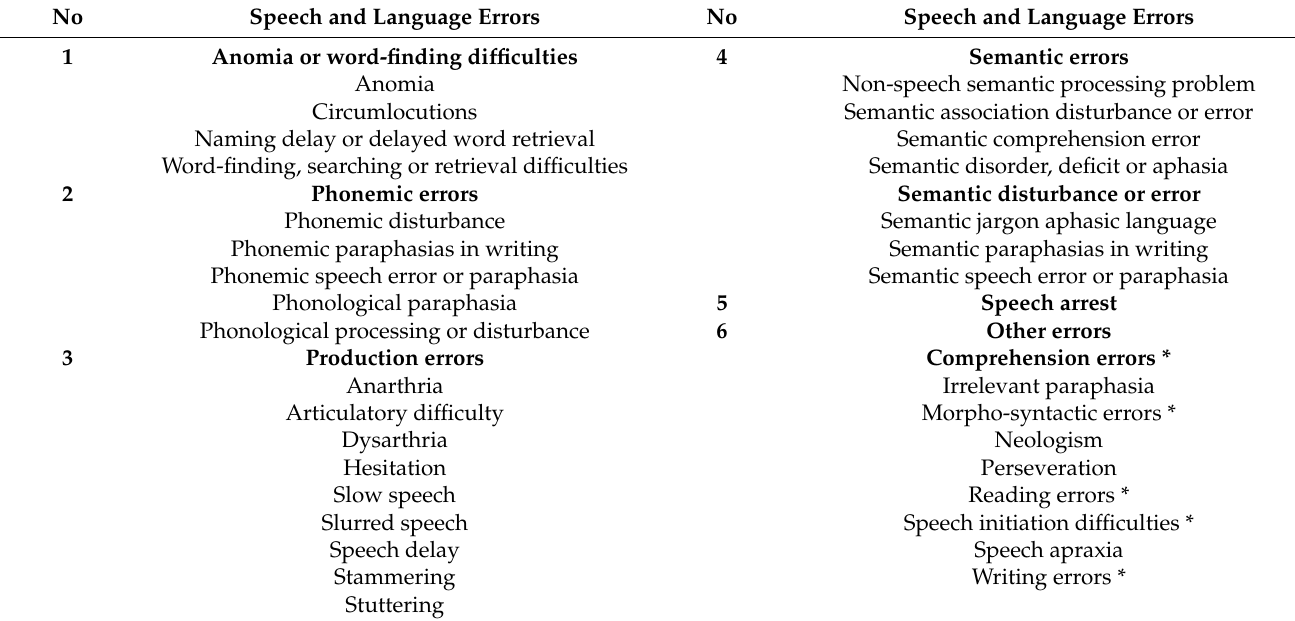
Table 1. Intraoperative speech and language errors taken from the articles and their corresponding categories (in